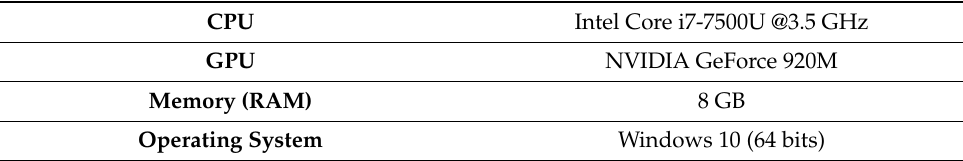
Table 1. The specifications of the server used in the study.